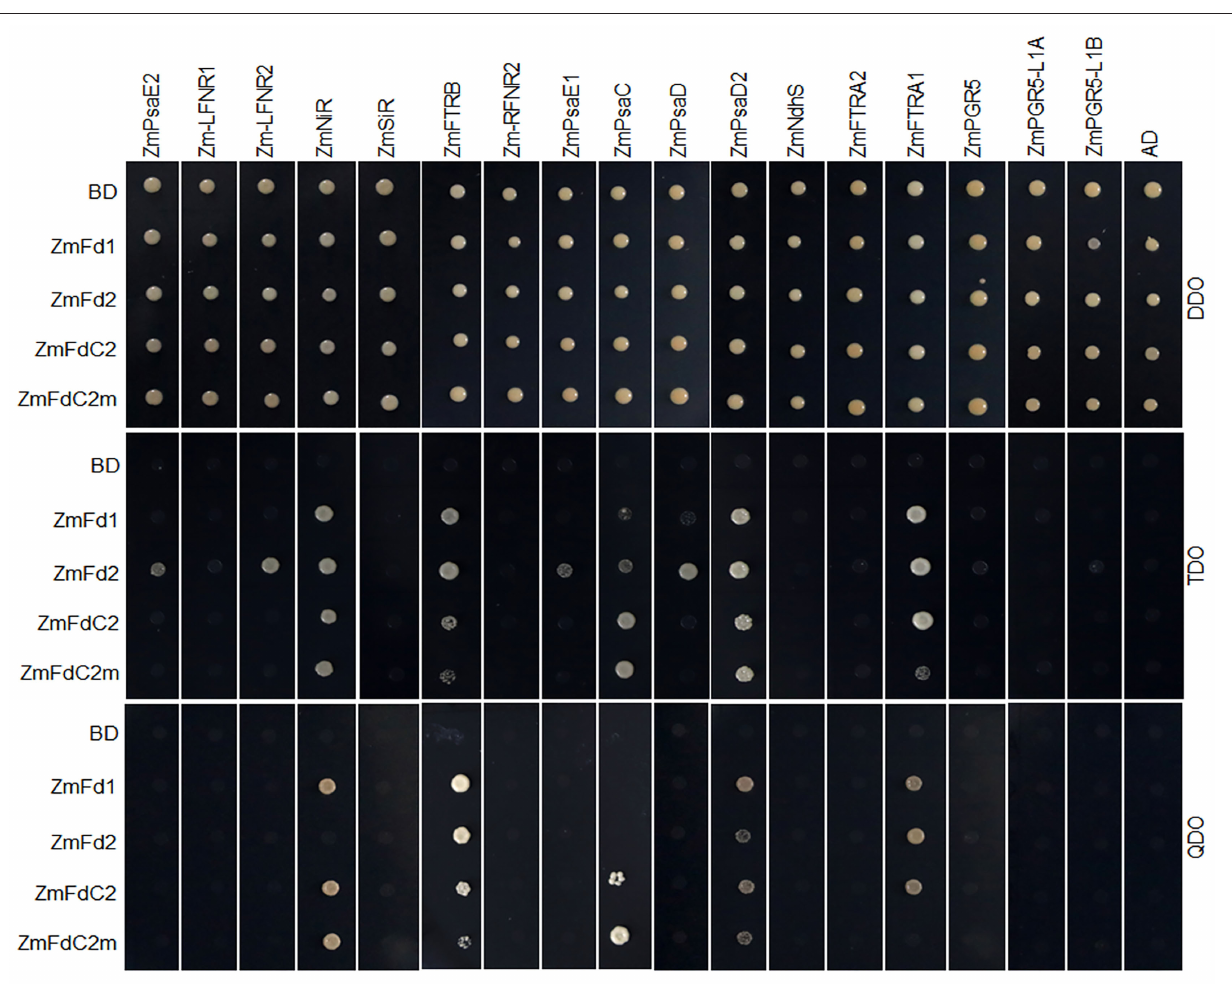
FIGURE 4 | ZmFdC2 interacted with PET proteins of maize. ZmFdI , ZmFdII , ZmFdC2 and ZmFdC2m were constructed into yeast two-hybrid bait plasmid (BD), and other maize PET genes were constructed into prey plasmid (AD). Yeast transformants were selected on DDO (SD/-Leu/-Trp) agar medium and the protein interactions were tested on TDO (SD/-Leu/-Trp/-His) and QDO (SD/-Leu/-Trp/-His/-Ade) agar